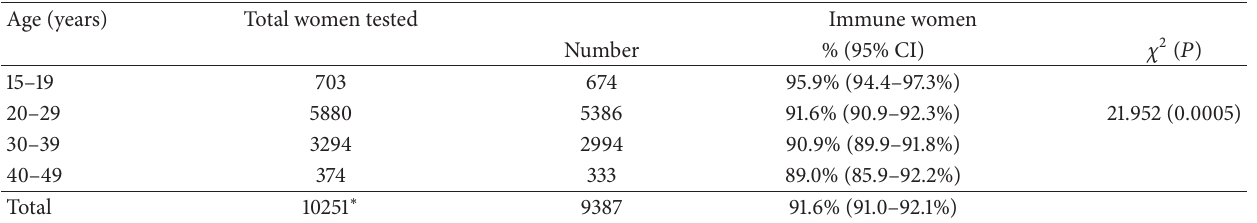
Table 3: Immunity rate to rubella as a function of age in pregnant women from Jeddah and the Western region of Saudi Arabia. Age (years)